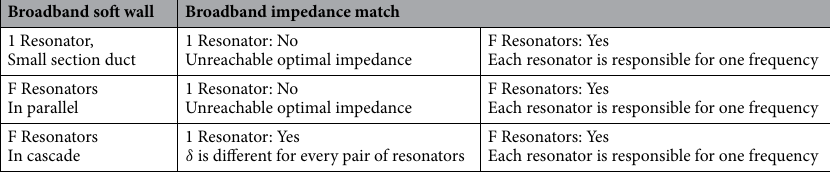
Table 1. Broadband perfect absorption, number of